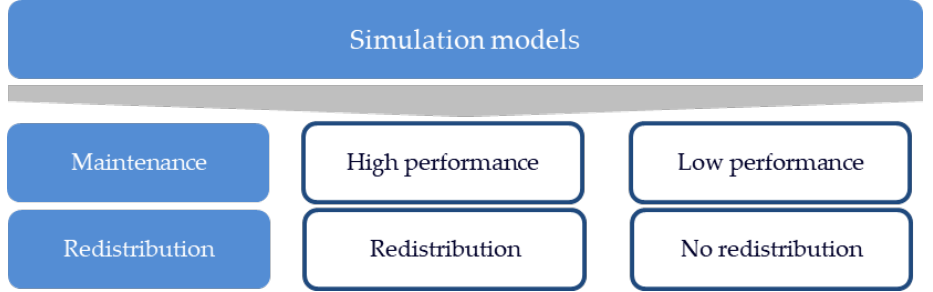
Figure 15. Simulation models.